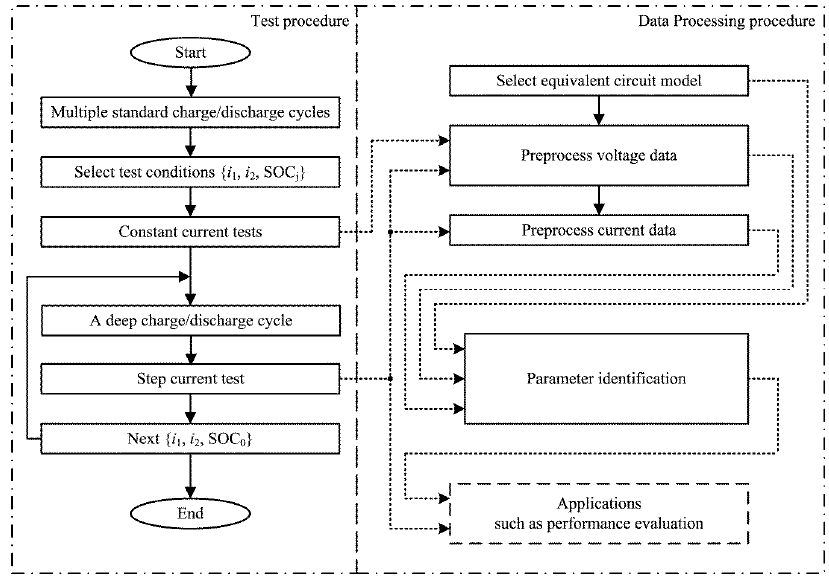
Figure 5. Parameter identification procedures.